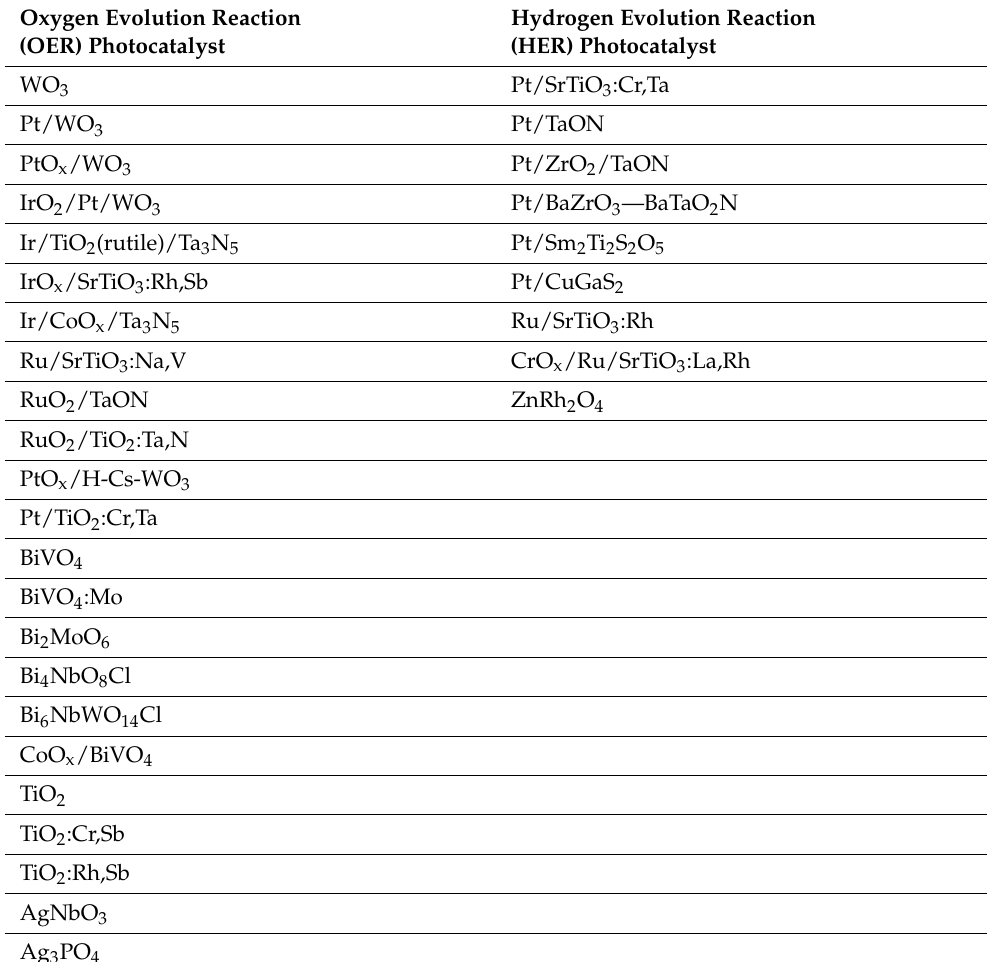
Table 1. Oxygen evolution reaction (OER) and hydrogen evolution reaction (HER) photocatalysts. Oxygen Evolution